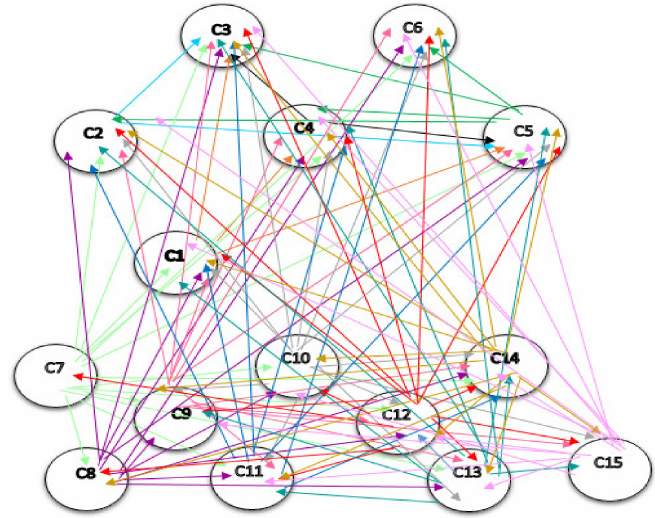
Figure 4. The network structure among the components. C1: Instructed. C2: Interconnected.